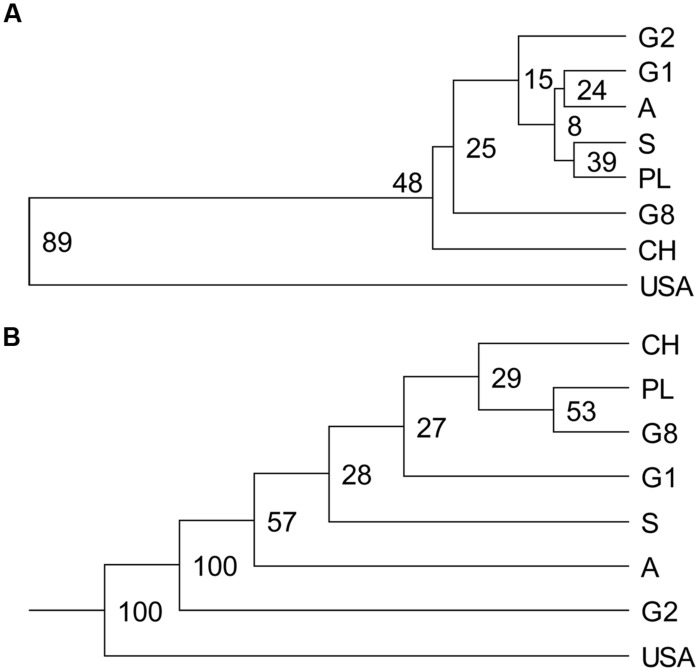
Unweighted pair group method with arithmetic mean dendrograms based on genetic distances calculated from both SSRs and AFLPs. (A)
Nei’s (1972) genetic distances based on SSRs between demes was used to construct the UPGMA dendrogram. (B) Consensus UPGMA dendrogram was drawn based on genetic dissimilarity between demes (genetic similarity based on simple matching coefficient) calculated from AFLPs. Numbers at nodes are percentage over 1000 bootstrap replicates. Abbreviations for the demes are as in Table 1.